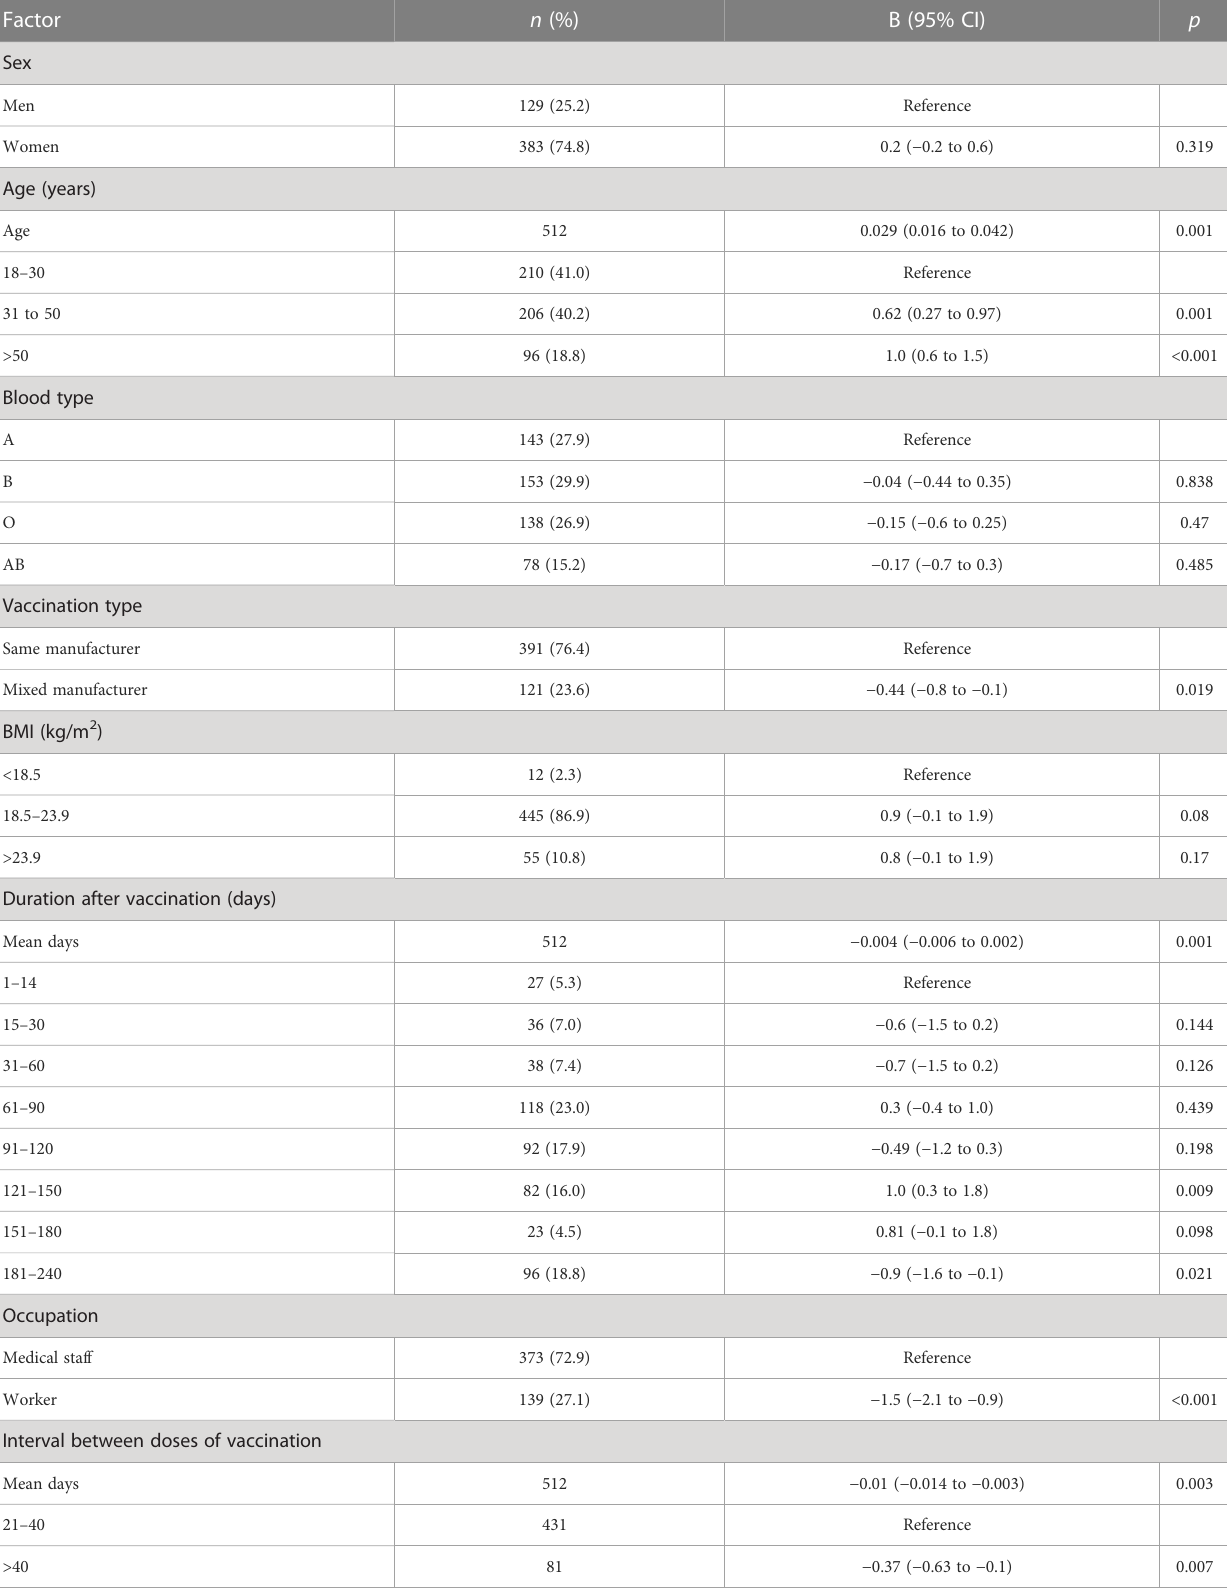
TABLE 6 Factors associated with IL-6 level after the administration of the Chinese COVID-19 inactivated